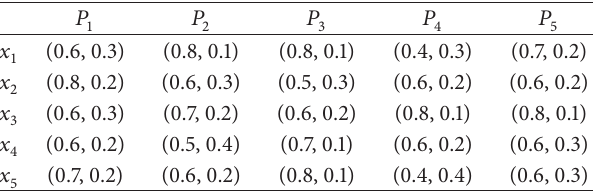
Table 4: Intuitionistic fuzzy decision matrix 𝑅 (3)